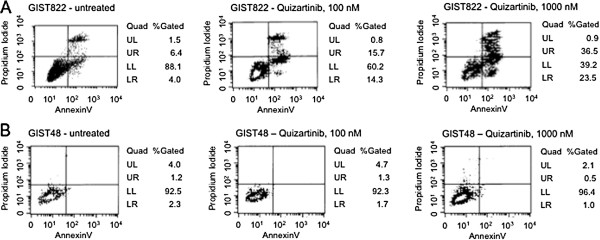
Quizartinib selectively induces apoptosis in gastrointestinal stromal tumor (GIST) cells. The imatinib-sensitive cell line GIST822, harboring a KIT K642E mutation (A) and the imatinib-insensitive cell line GIST48, harboring a KIT V560D plus an additional D820A mutation, were treated with quizartinib for 7 days and assayed for induction of apoptosis. Quadrant density dot plots are provided showing the apoptotic cell fraction as indicated by annexin V positivity (LR quadrant: early apoptosis) and/or positive propidium iodide stain (UR: late apoptosis, UL: dead cells) of quizartinib-treated versus treatment-naive cells. Estimated IC50s by non-linear dose regression analysis are provided with Table 2.